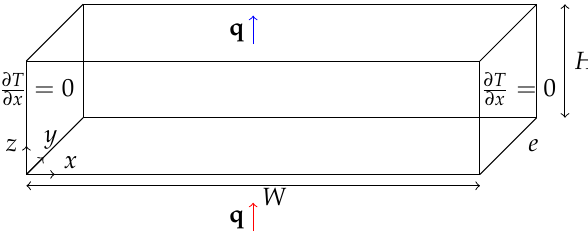
Figure 1. The porous rectangular cavity heated from below by a constant